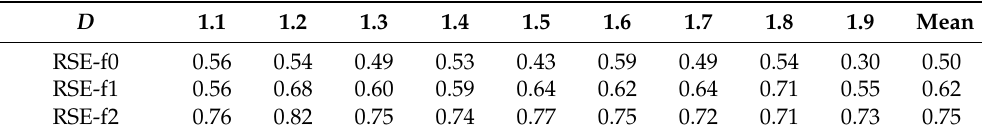
Table 2. The increasing range slopes of Figure